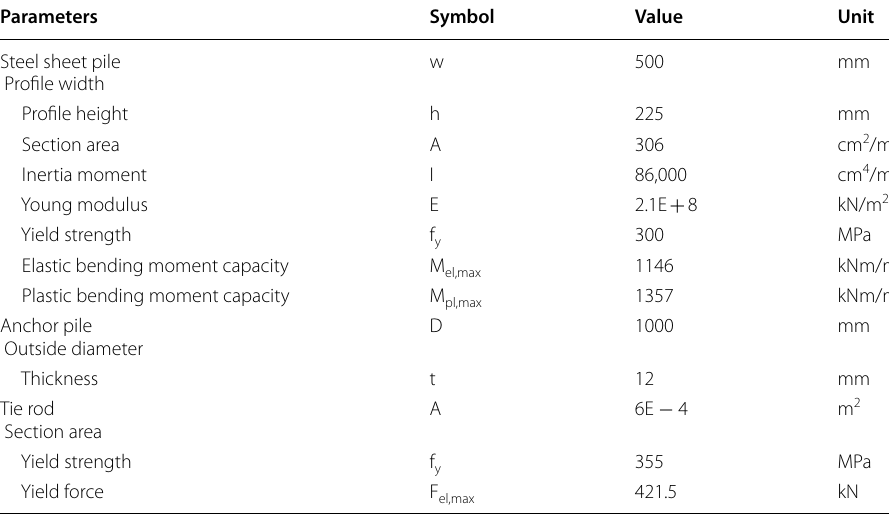
Table 1 Properties of structures [15]